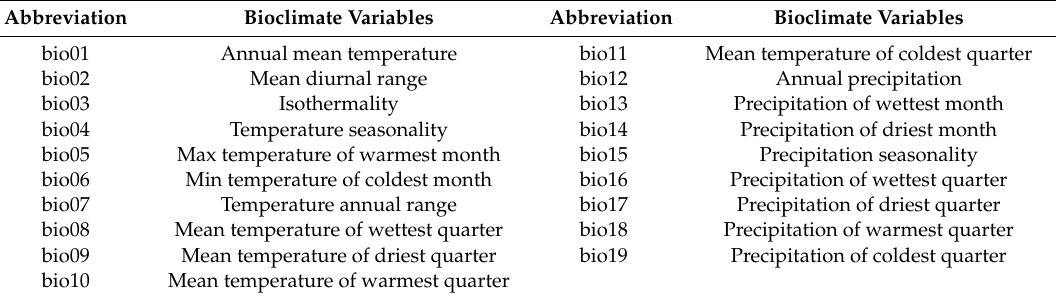
Table 1. List of meteorological